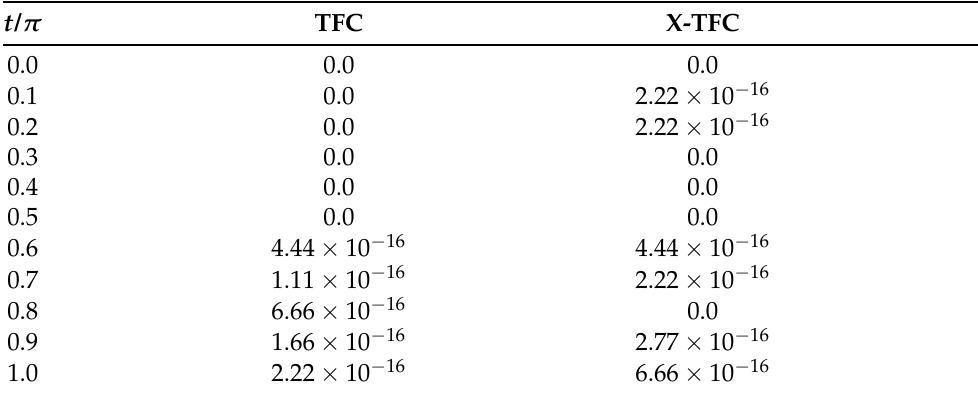
Table 1. Absolute errors on uniform test points for problem